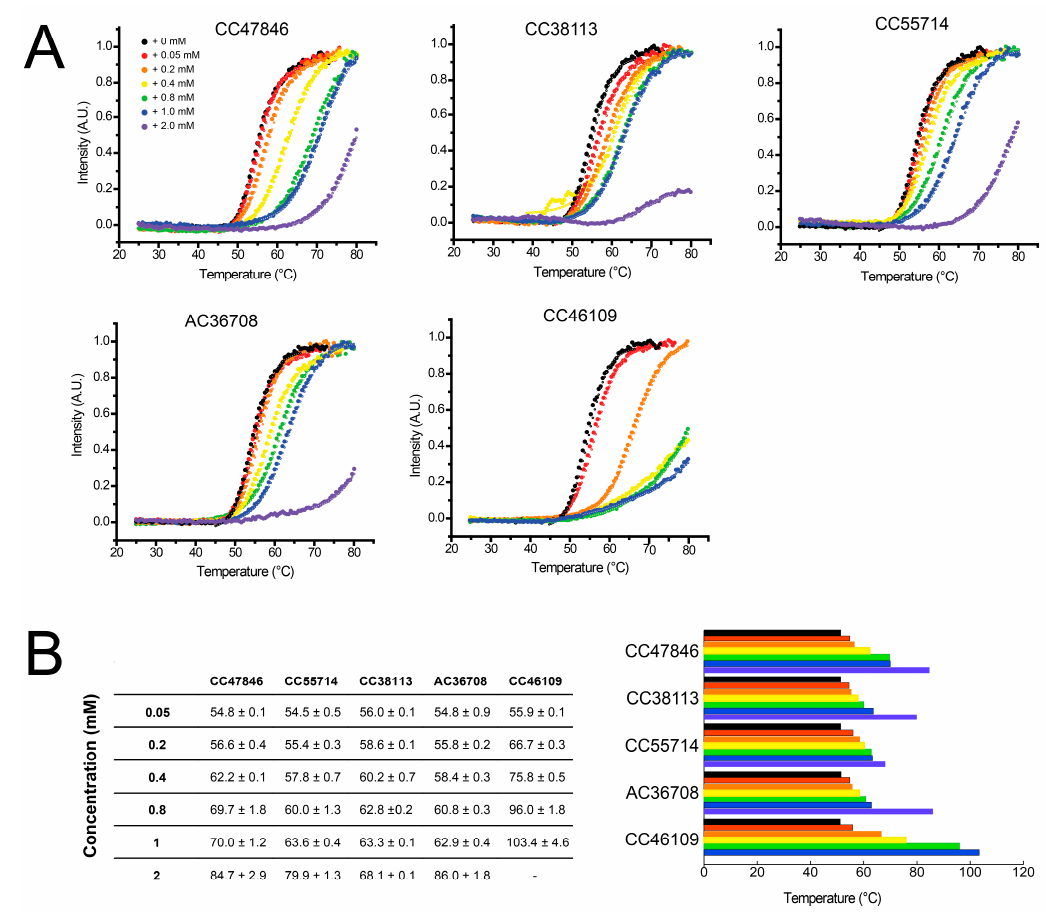
Figure 8. Dose-dependency of hit fragments on T agg of hAQP1. ( A ) thermal denaturation curves of hAQP1 in the presence of increasing concentrations of each of the five selected hit fragments. Light scattering intensities are plotted as a function of temperature and fitted to the Boltzmann equation by non-linear regression to obtain the temperature of aggregation, T agg ; ( B ) table of the average T agg values of purified hAQP1 in the presence of hit fragments at increasing concentrations. Each value is the average of three independent measurements. These values are plotted as a histogram ( right ), where colors represent drug concentrations shown in Figure 8A.